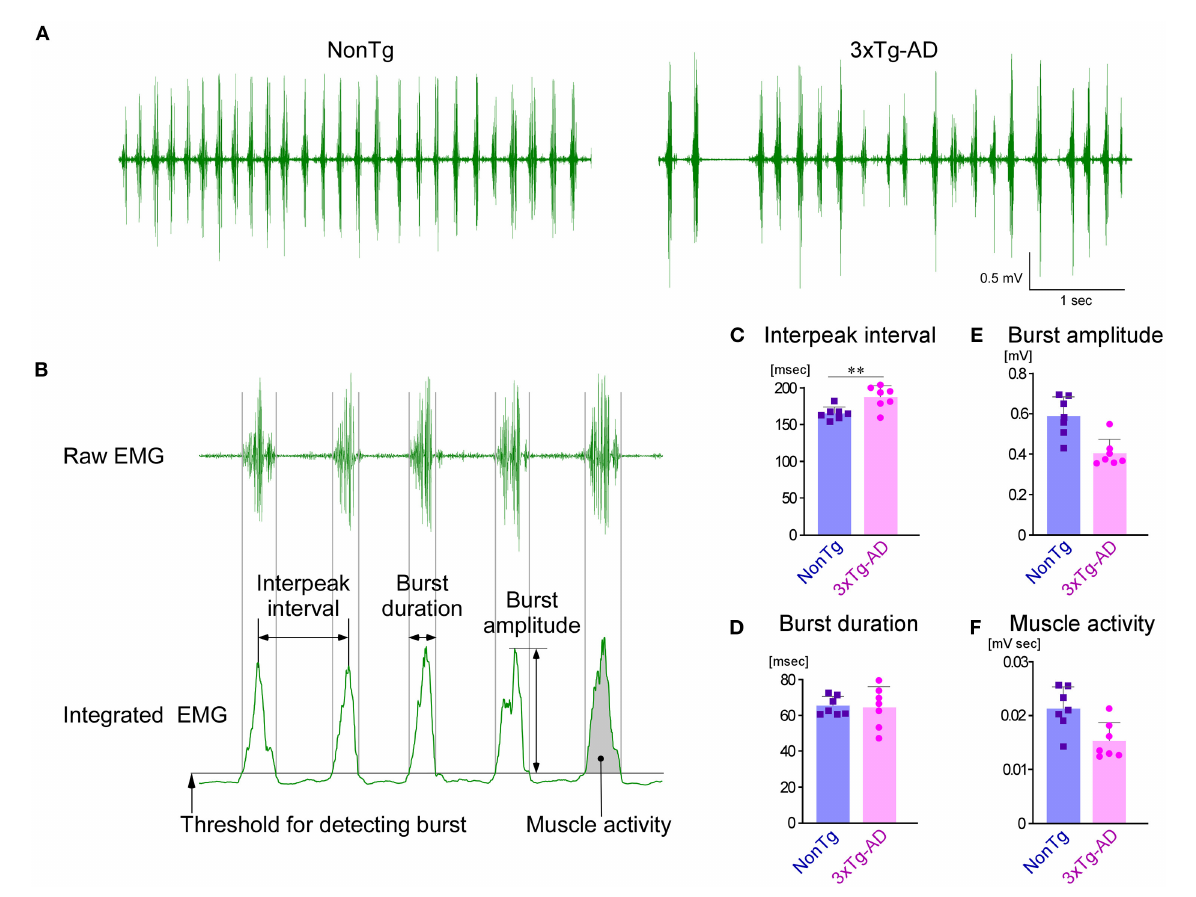
FIGURE4 Comparison of EMG findings in the masseter muscles during sunflower seed chewing between NonTg and 3 × Tg-AD mice. (A) Representative raw EMG recordings of the masseter muscles in 3–4-month-old NonTg and 3 × Tg-AD mice. The rhythm of the chewing cycle was more irregular and slower in 3 × Tg-AD mice than in NonTg mice. (B) EMG findings in five or more consecutive chewing cycles were analyzed. The details of how each parameter was measured are provided in the Section Materials and methods. The 3 × Tg-AD mice ( n = 7) showed a significantly longer mean interpeak interval of bursts than did NonTg mice ( n = 7) ( C ; ** P = 0.0065, two-tailed unpaired t -test), but there was no difference in the mean duration of individual bursts ( D ; P = 0.8775, two-tailed unpaired t- test). Because the amplitude of bursts (E) and muscle activity (F) were greatly affected by the state of the electrodes in the EMG, they could not be compared between